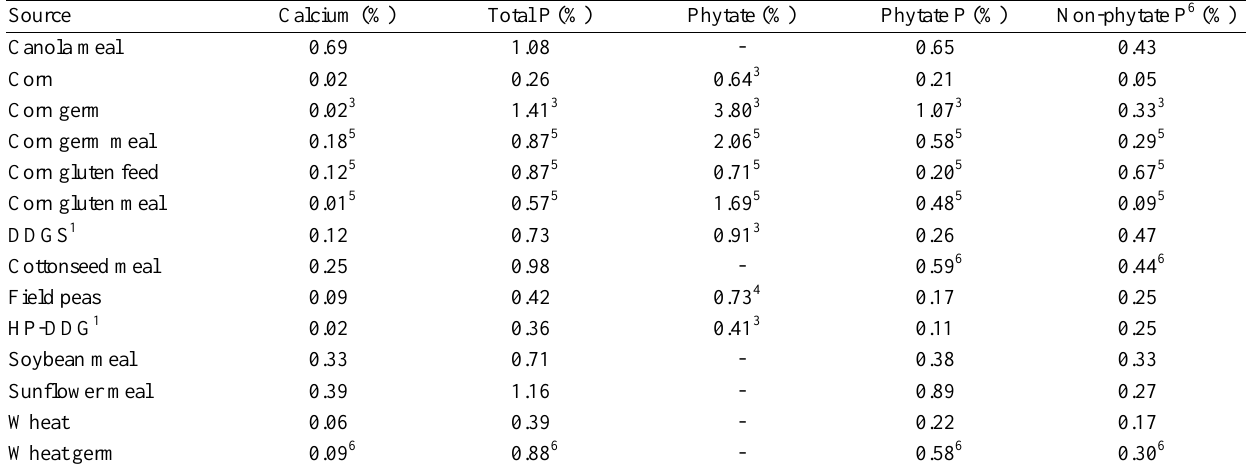
Table 2. Calcium, phosphorus (P), and phytate concentration in common feed ingredients of plant origin